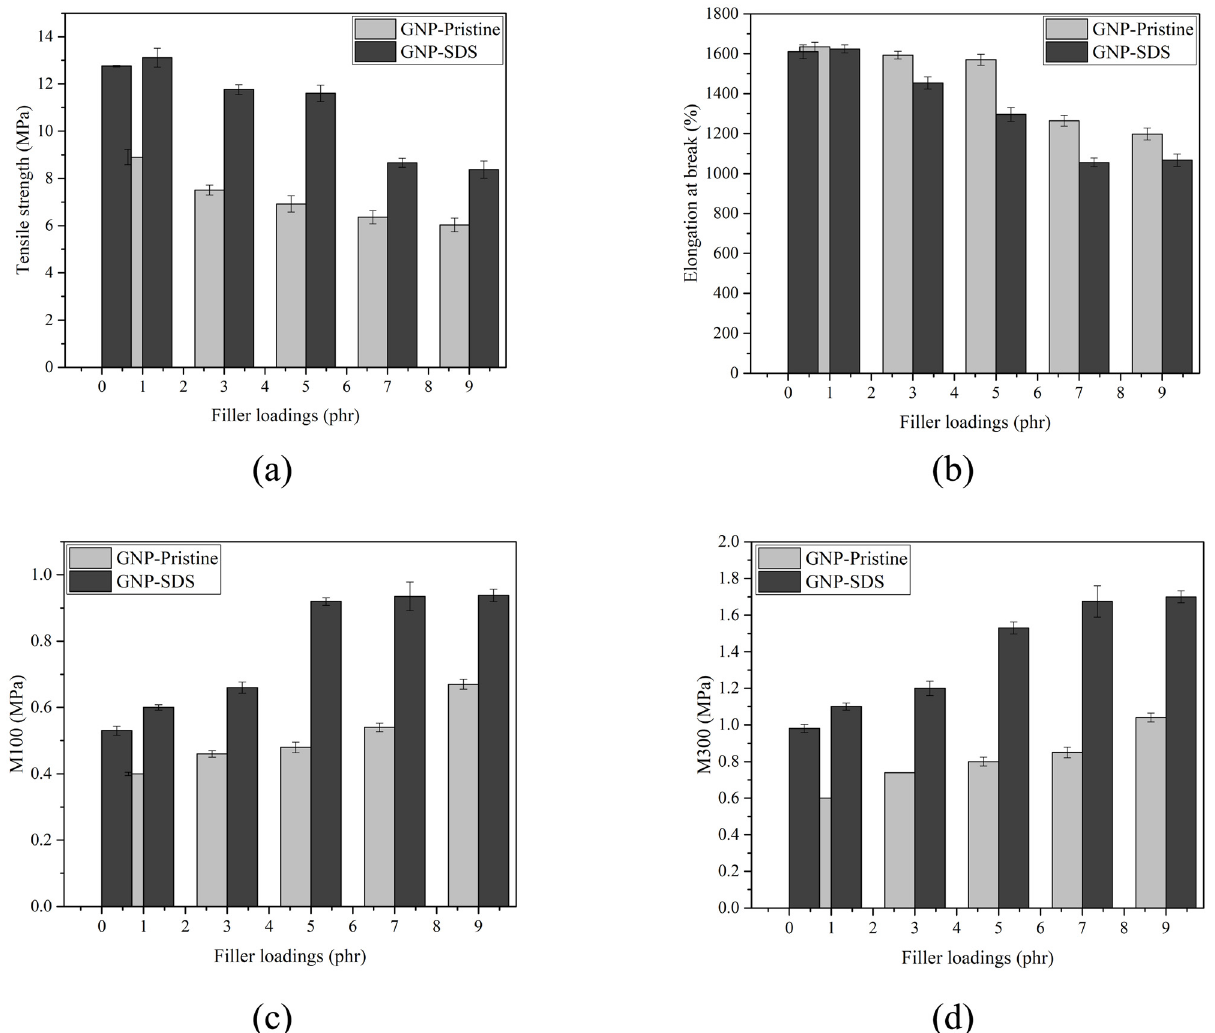
Figure 6: Tensile properties: ( a ) tensile strength, ( b ) elongation at break, ( c ) M100, and ( d ) M300 of NRL/GNP - pristine and NRL/GNP – SDS with increasing